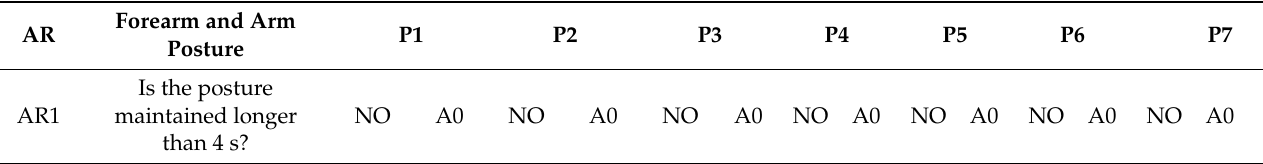
Table A4. Forearm and arm posture evaluation.